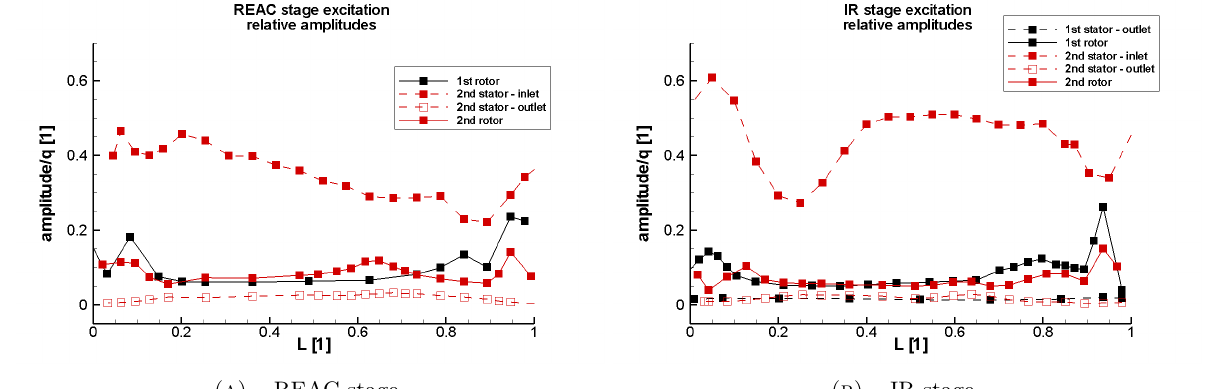
Figure 5. Relative total pressure